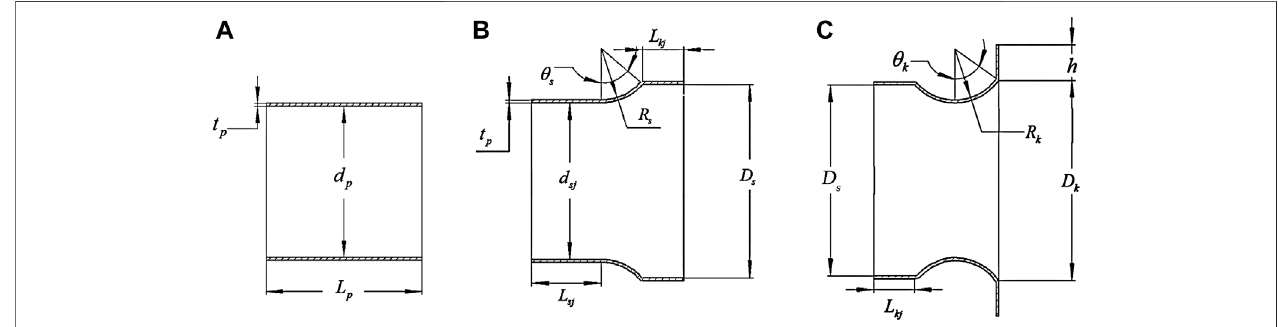
FIGURE 4 | (A) Geometry model of the blank of a wind concentrator. (B) Contraction segment after DRCS. (C) Expanding segment after DRCS.